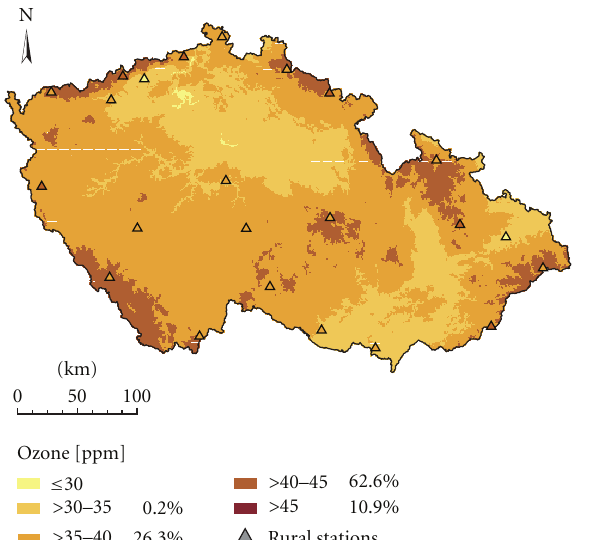
Figure 3: Spatial interpolation of mean O 3 concentrations in the 2008 vegetation season (ppb), interpolation technique ALR + res OK, grid resolution 1 × 1km.